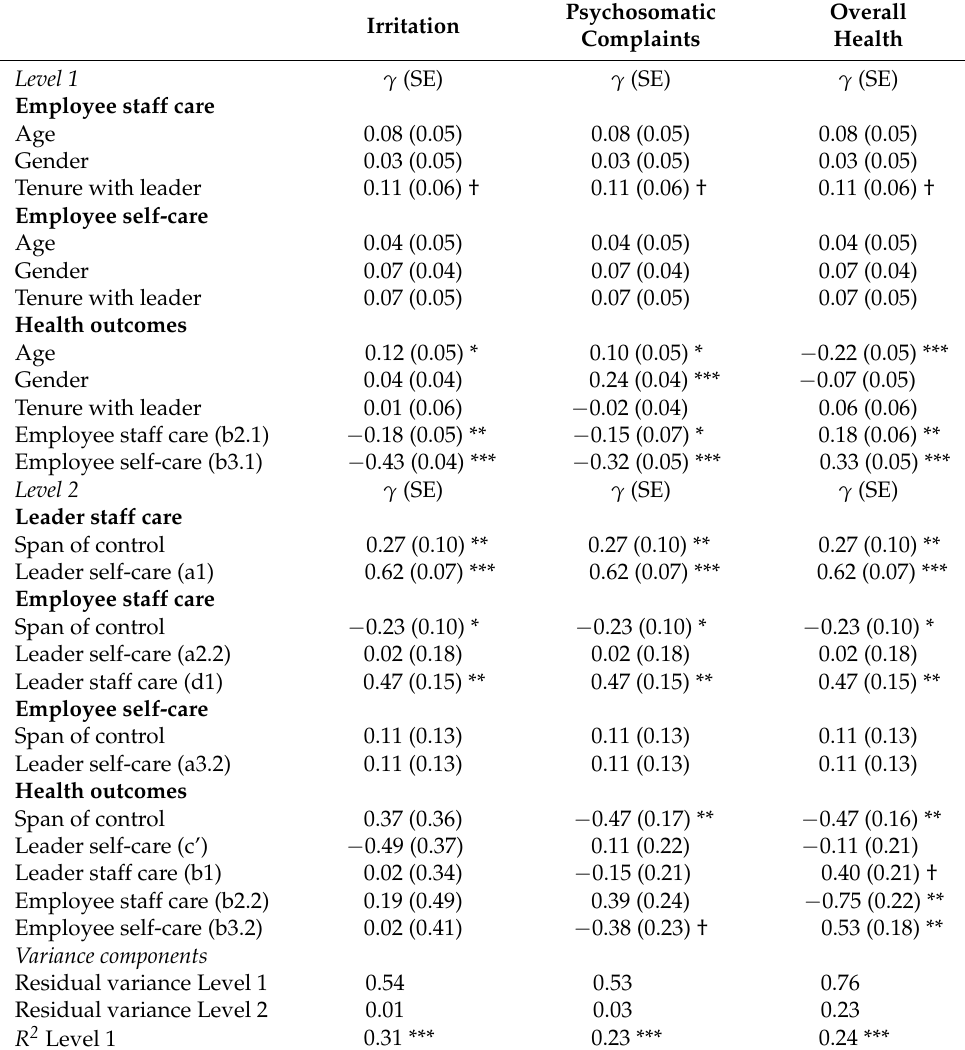
Table 2. Standardized coefficients from multilevel path analysis of irritation, psychosomatic com- plaints, and overall